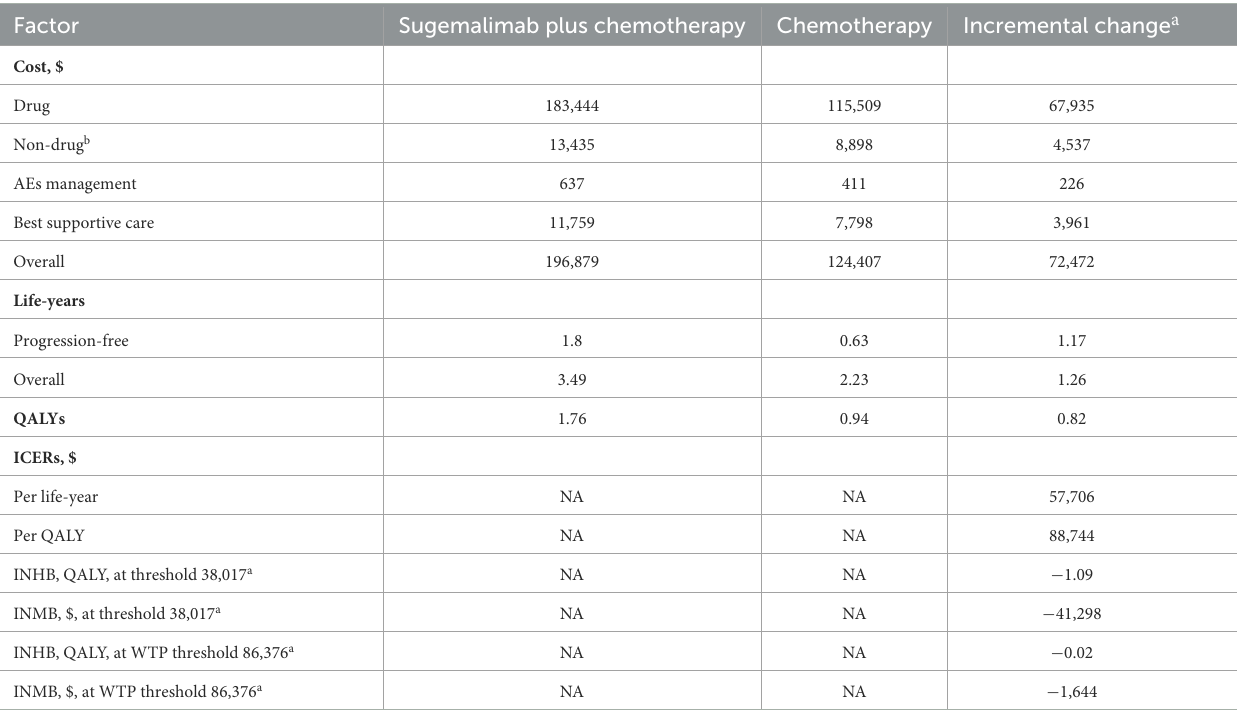
TABLE 2 Summary of cost and outcome results in the base-case